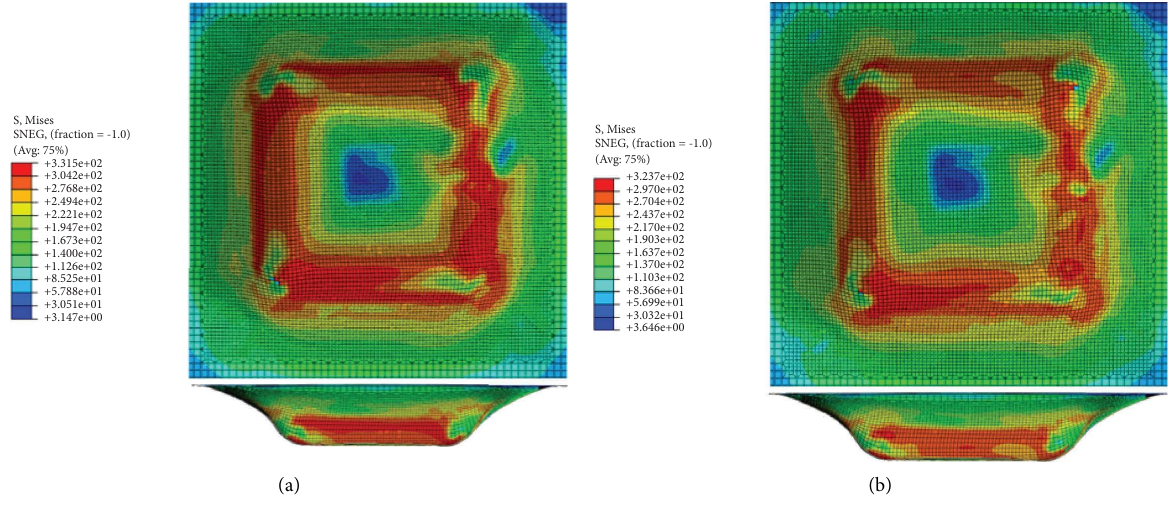
Figure 9: Simulation results of stress: (a) with UV; (b) without